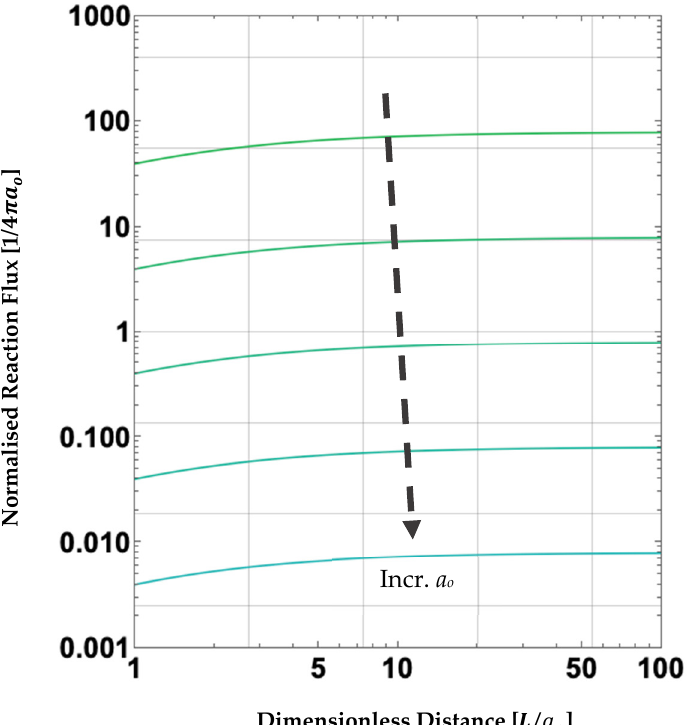
Figure 7. Log-Log parametric plot of diffusion-limited reaction fluxes for two reaction zones (diffusive sinks), which depend on the reaction zone radii, a o , and the centre-to-centre distances between these zones, L . Note that the smaller the reaction zone, the more rapid the diffusion-limited reaction flux.